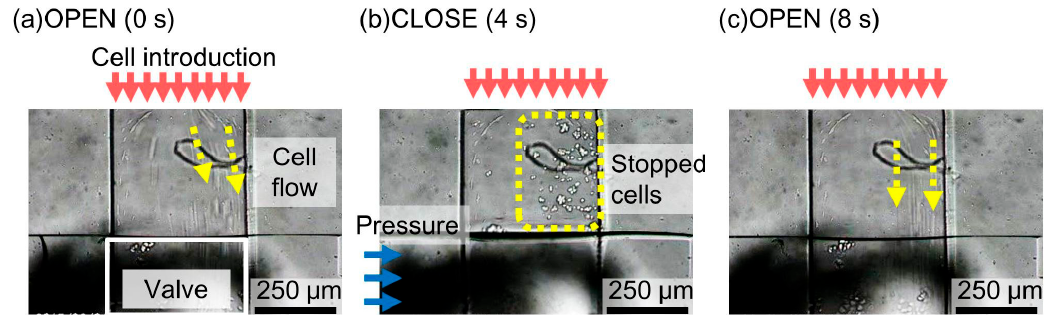
Figure 12. Damming of the cell suspension flow using the microvalve. ( a ) Cells in the cell suspension pass through the microvalve when the micro valve is open; ( b ) cells stops when the micro valve is closed; ( c ) cells flows againg when the micro valve is reopened.